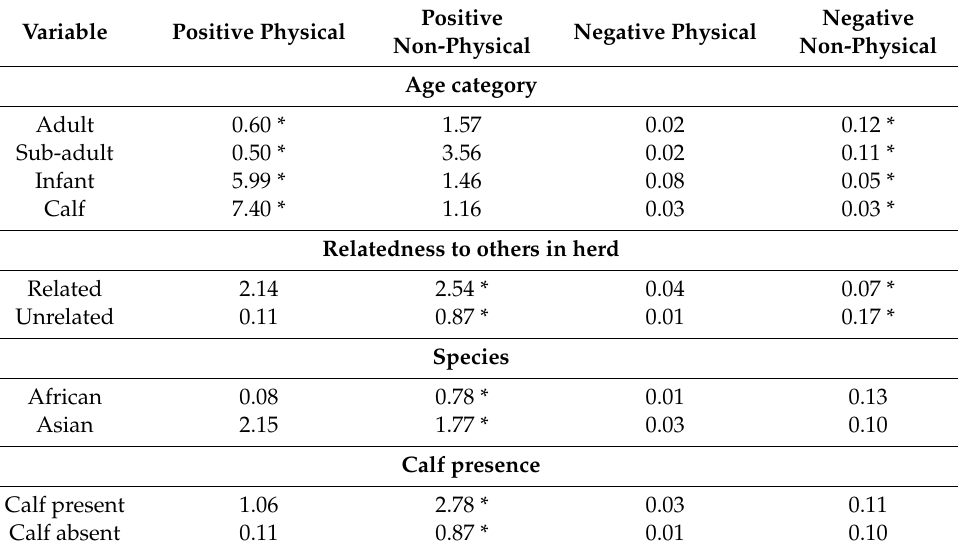
Table 4. Median percent of social interactions for categorical variables assessed during